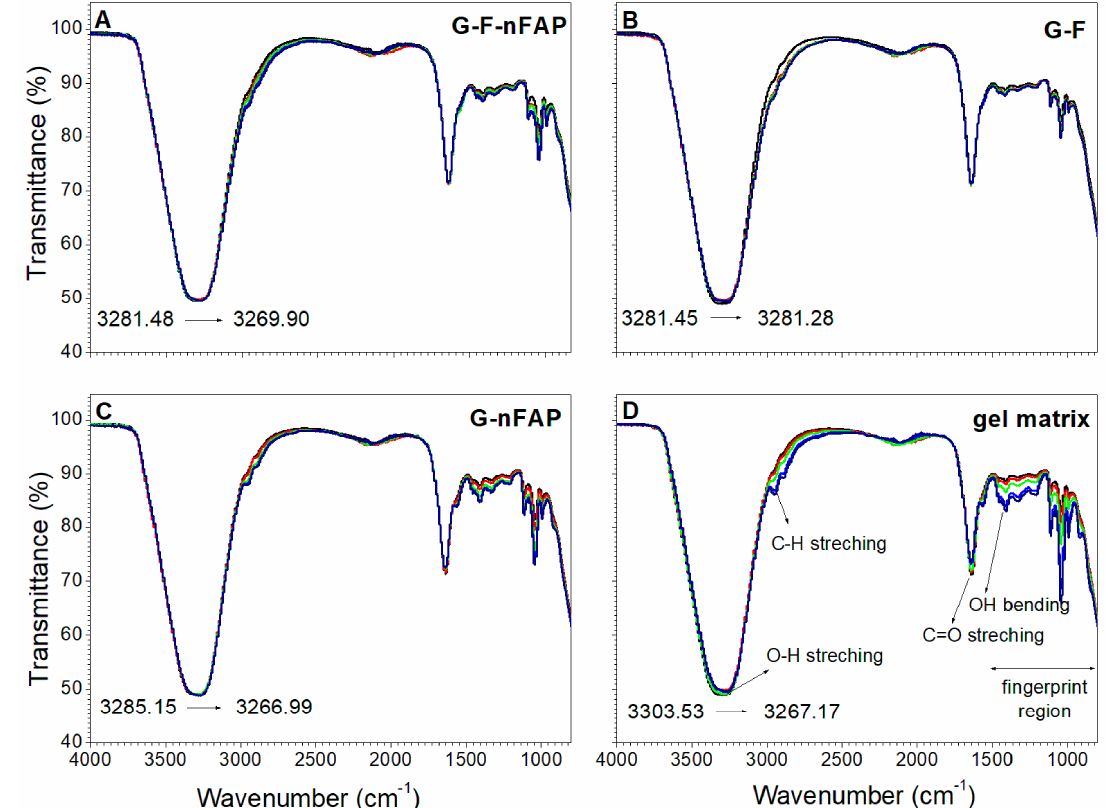
Figure 5. The FT − IR spectra of the gel formulations (G − F-nFAP gel ( A ), G − F gel ( B ), G − nFAP gel ( C ), and gel matrix ( D ). The gels were tested during the first (black), second (red), third (green), fourth (blue), and fifth (navy line) weeks of the experiment.